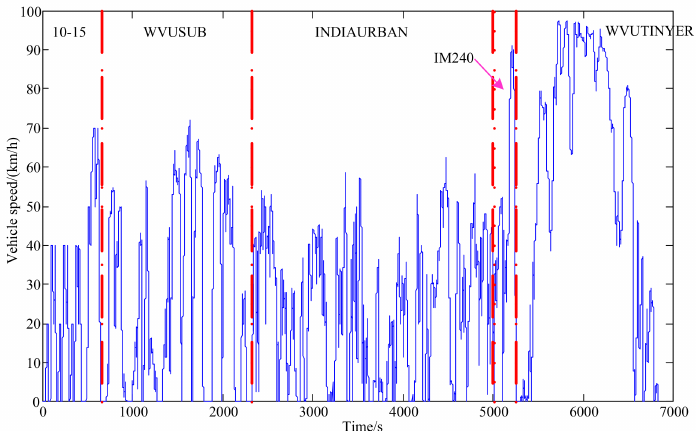
Figure 12. Comprehensive driving